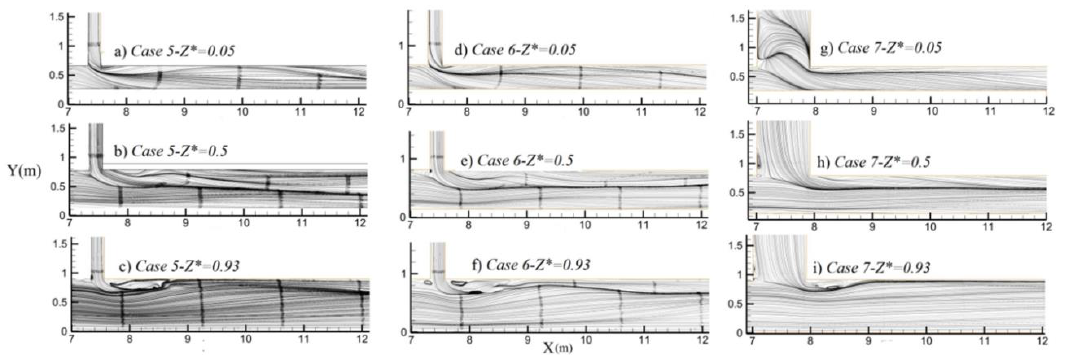
Figure 10. The distribution of the normal component of velocity (V) in trapezoidal channel.